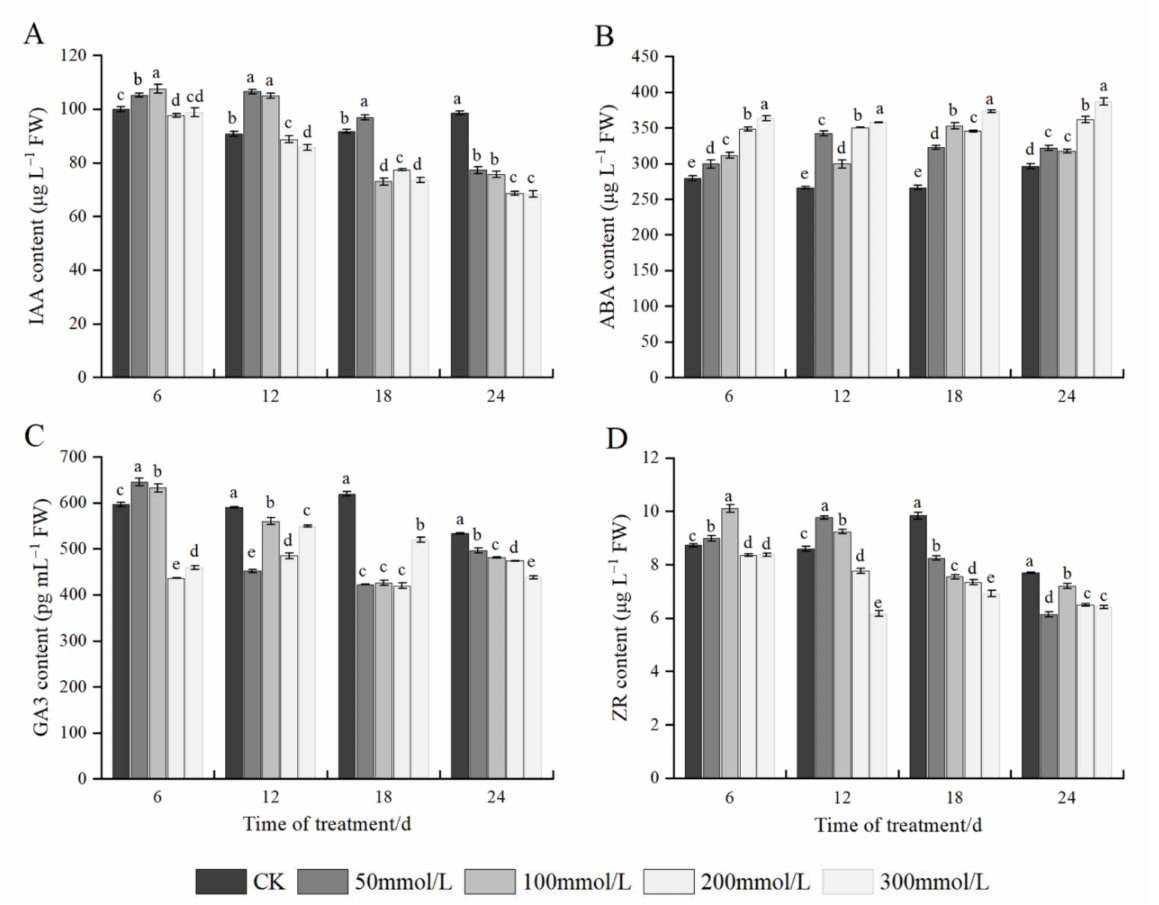
Figure 6. Effect of salt stress on endogenous hormones of J. microcarpa L. seedlings. ( A ) Indole-3-acetic acid (IAA), ( B ) abscisic acid (ABA), ( C ) gibberellic acid 3 (GA3), and ( D ) zeatin riboside (ZR) of the leaves. Error bars indicate the SD of treatment means. Different letters on the bars indicate significant differences among the treatments ( p <